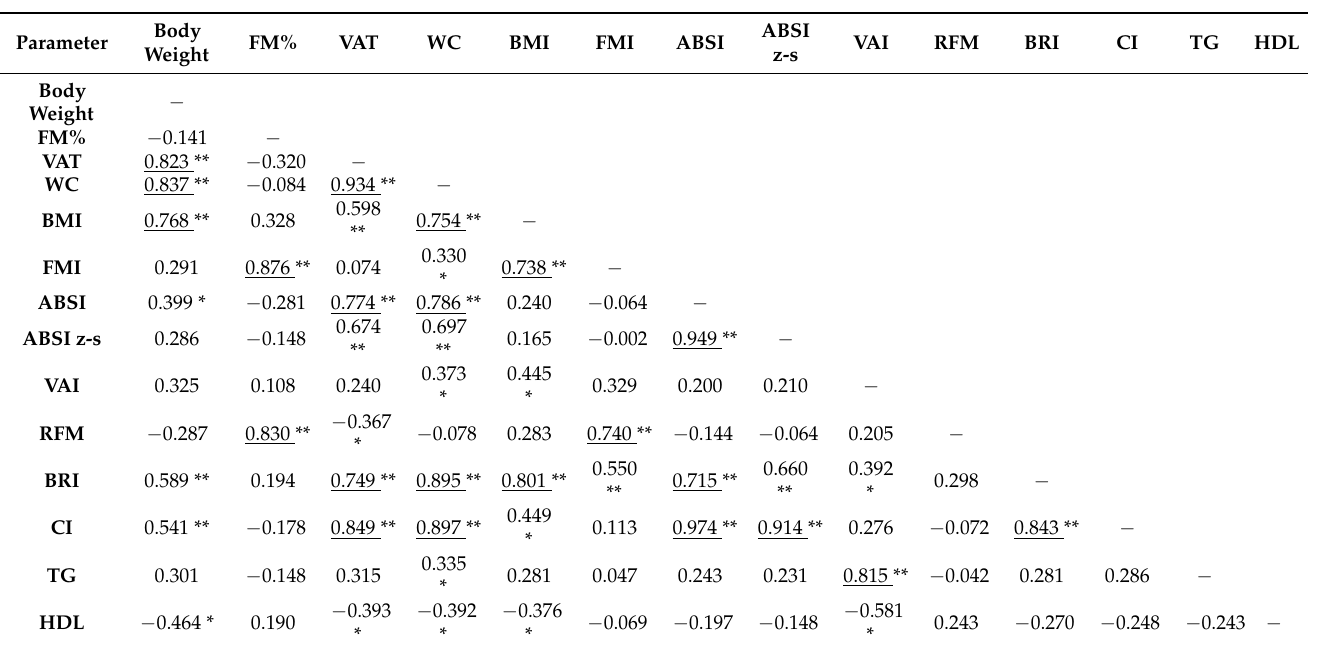
Table 3. Pearson’s rank correlation for body mass composition measurements and blood parameters at the baseline.